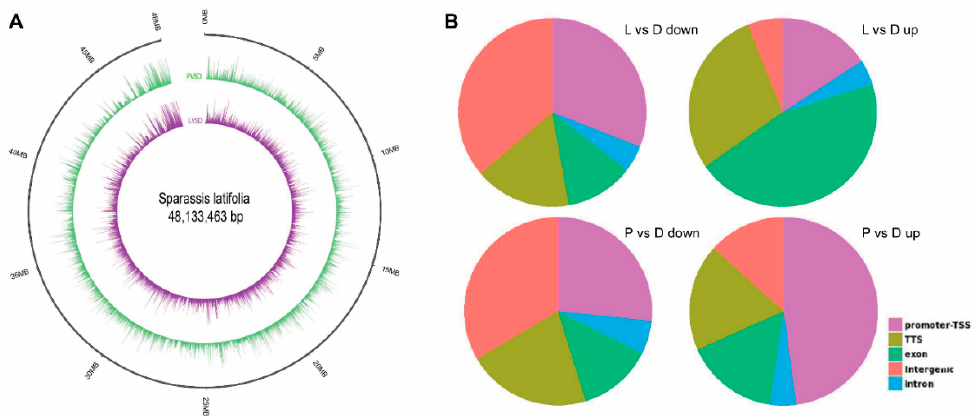
Figure 2. Genomic distribution of differential peaks. ( A ) Circos map of differential peaks. ( B ) The genome-wide distribution of the peaks. The genome-wide functional regions were divided into promoter, downstream TTS, coding exon, intron, and distal intergenic regions.